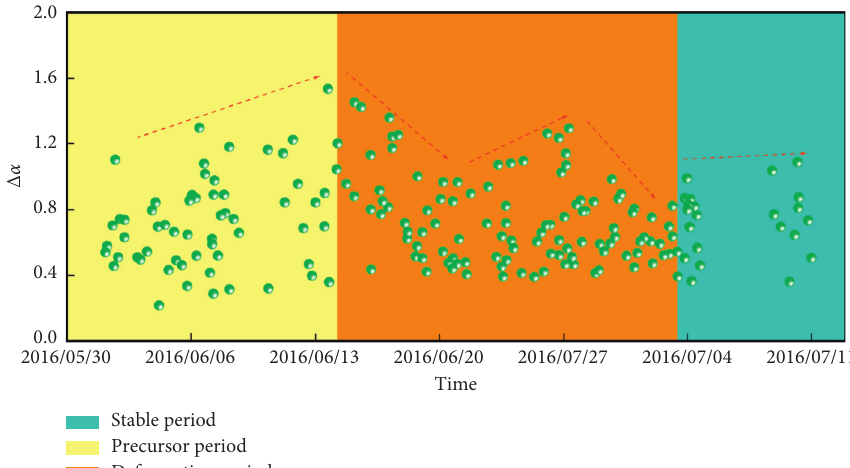
Figure 16: Stage division based on